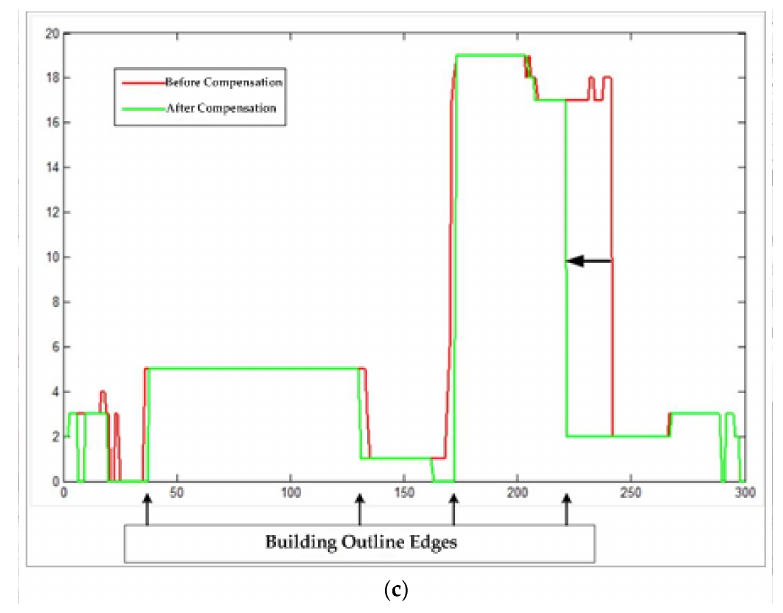
Figure 12. The disparity map compensation by outline feature ( a ) One row of disparity map ( b ) The split stereo display on this row ( c ) The profile optimization of disparity map on this